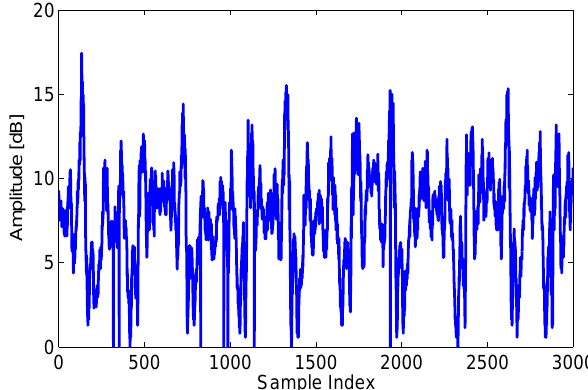
Figure 2. Amplitude variation of center frequency subcarrier in a dynamic state.